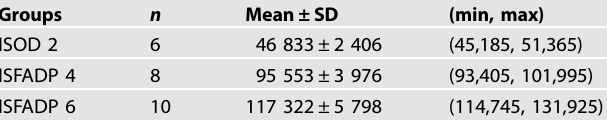
Table 4. Total cost (Euro) (Patient ’ s initial cost + post-treatment).